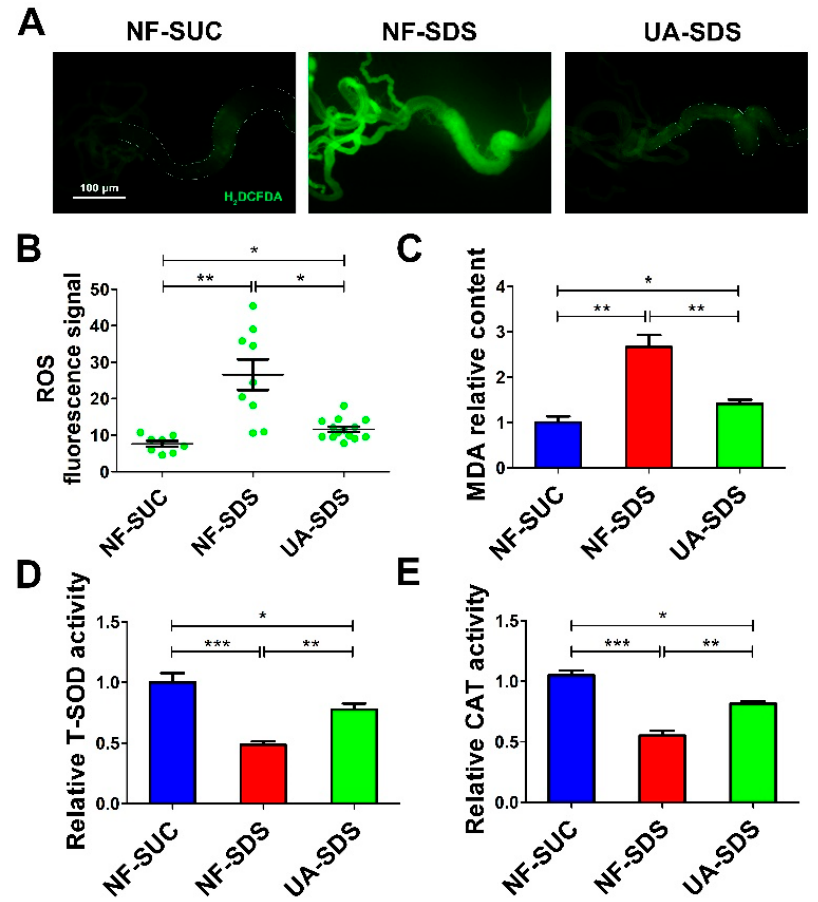
Figure 4. UA protected intestine from SDS-induced oxidative damage. ( A ) UA protected epithelial cells against SDS-induced oxidative stress. H 2 DCFDA staining of the anterior midgut of a female fly after ingestion of 0.5% for 48 h. ( B ) Fluorescence intensity of ROS levels in panels (n ≥ 10). ( C – E ) UA supplementation alleviated malondialdehyde (MDA) levels and increased the activities of total superoxide dismutase (T-SOD) and catalase (CAT), after exposure to SDS for 48 h. * p < 0.05, ** p < 0.01, *** p < 0.001.